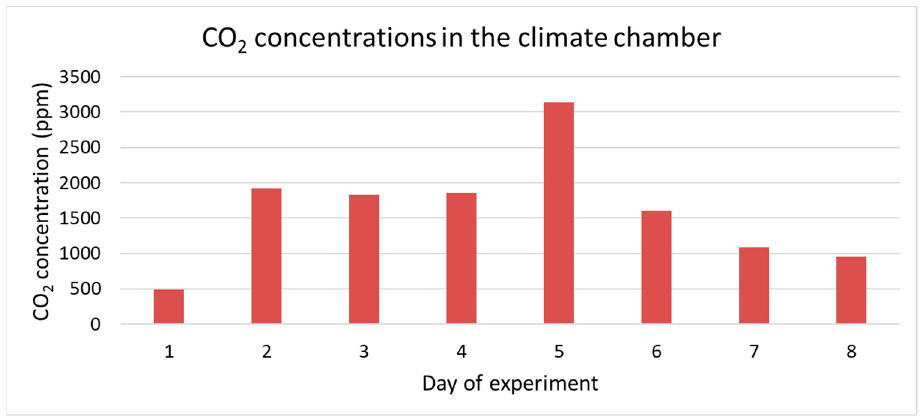
Figure 1. CO 2 concentrations measured in the climate chamber. NH 3 concentrations were at a low level until day 4 (Figure 2). NH 3 concentrations increased very fast to 63 ppm at day 5. NH 3 concentration remained at a level between 40 and 60 ppm after day 5.